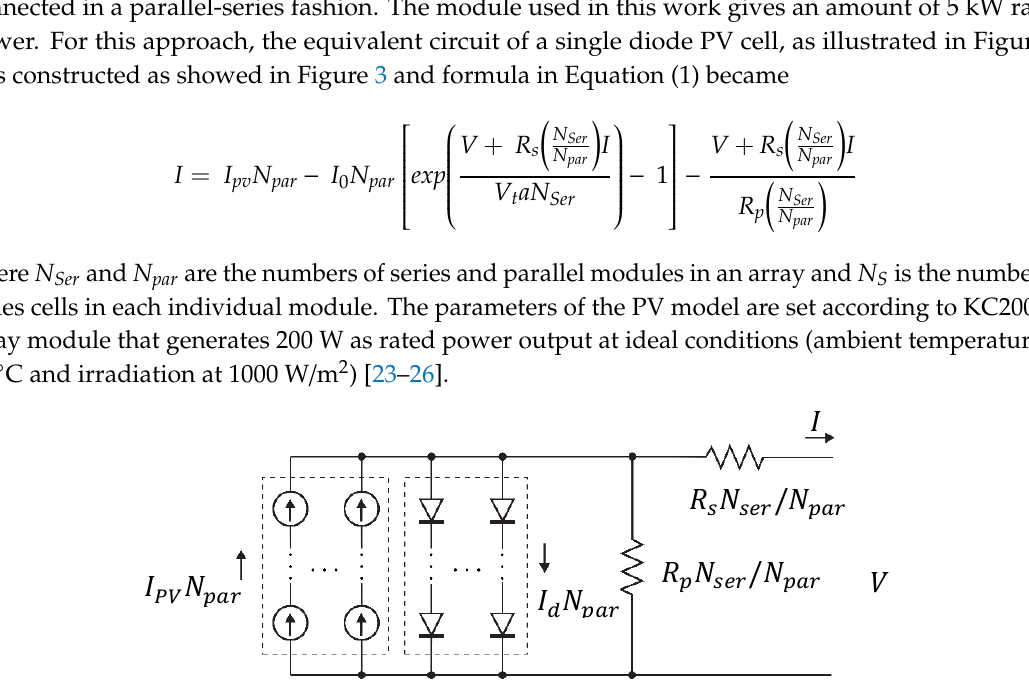
Figure 2. Equivalent circuit of a single diode photovoltaic (PV) cell.